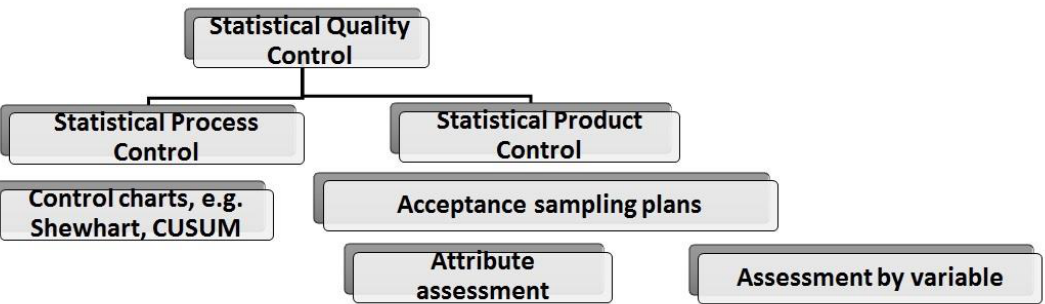
Figure 7. Scheme of quality control.